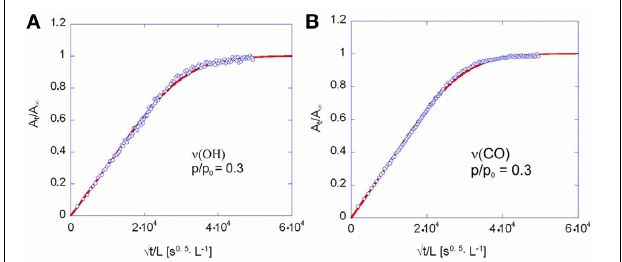
√ t / L ) obtained from the Figure 11 | Fick’s diagrams (i.e., A t / A inf vs. data of Figure 10A (A) and Figure 10C (B). Open circles represent experimental data, solid lines are the least-squared best-fitting of the data points with Equation 4. The diffusion coefficient, D in Equation 4 was the sole parameter allowed to change in the fitting process.